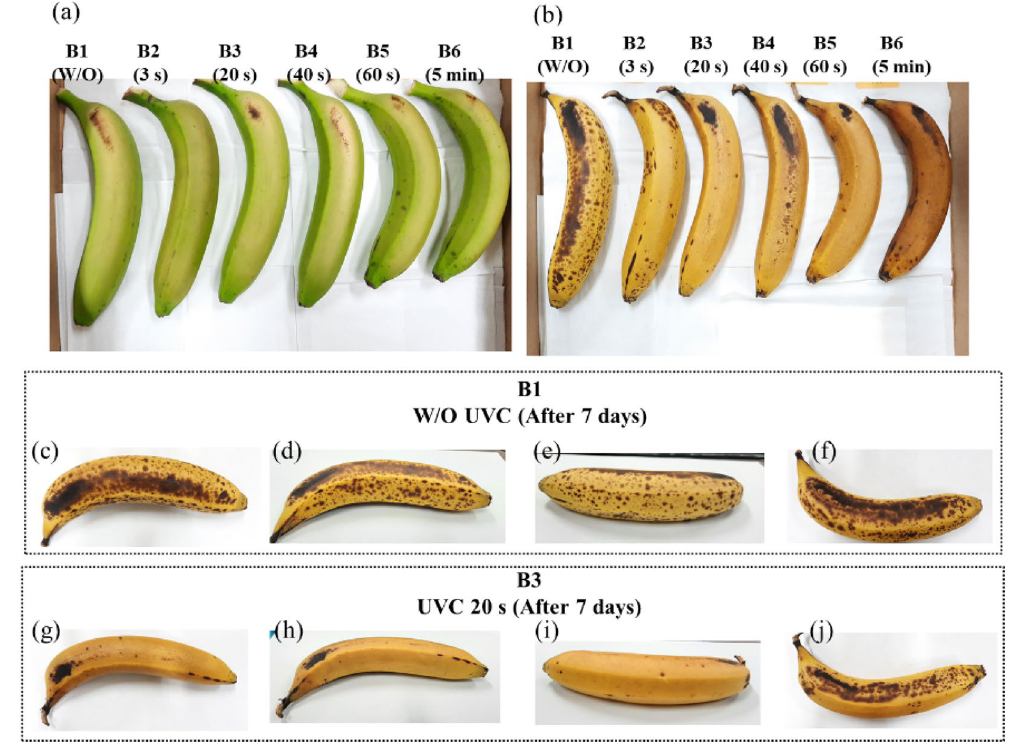
Figure 12. ( a ) Six banana samples were prepared for irradiation with UVC light at different exposure times, where samples B1, B2, B3, B4, B5, B6, B7 corresponded without UVC treatment (control), 3, 20, 40, 60 s, and 5 min, respectively; ( b ) after seven days from treatment time; sample B1 without treatment UVC light after seven days observed from ( c ) top view; ( d , e ) side view; and ( f ) bottom view; banana with treatment UVC